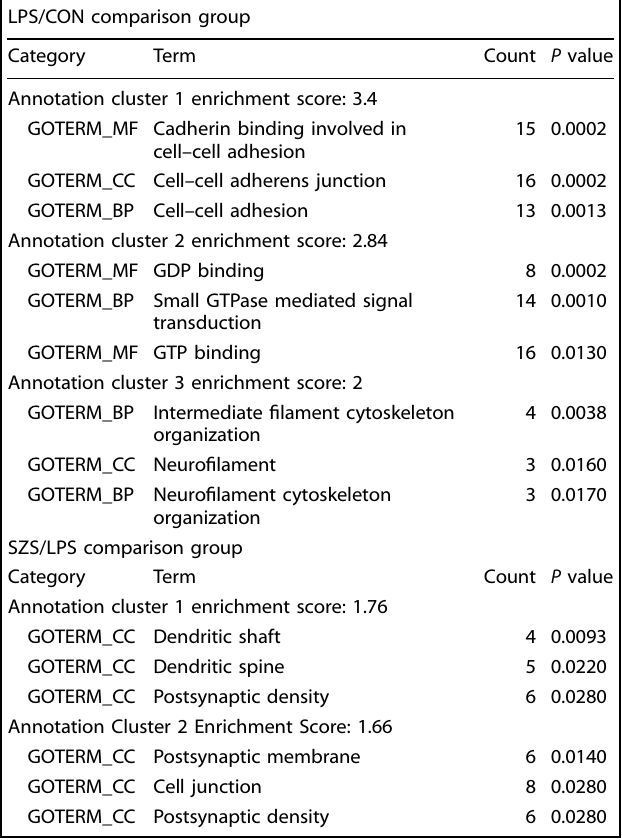
Table 1. Annotation clusters of differently expressed proteins